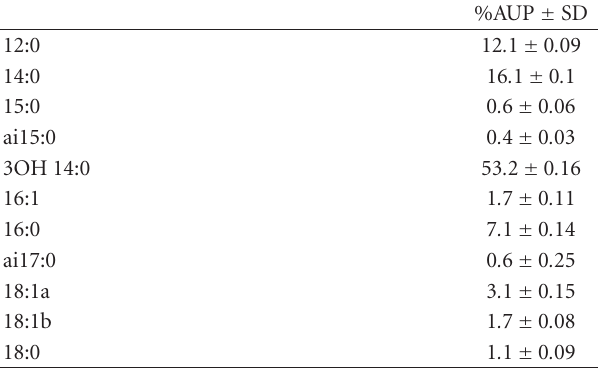
Table 3: Fatty acid profile of D. desulfuricans